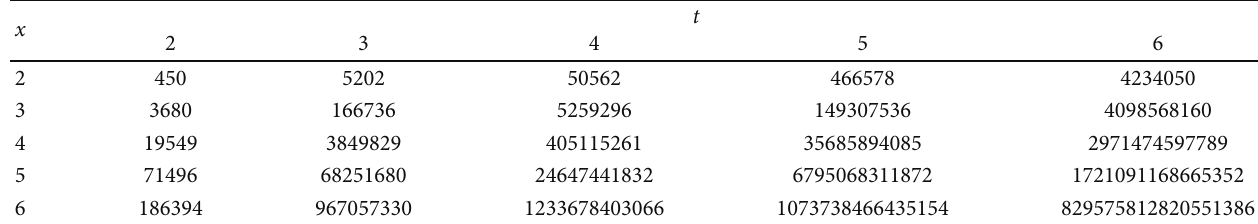
ð T ð 4, t ÞÞ , where x , t ∈ f 2, 3, 4, 5, 6 g n − x